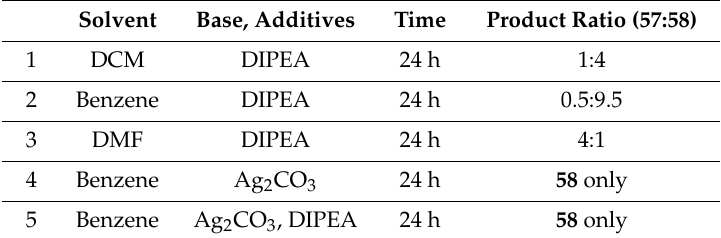
Table 2. Summary of conditions explored for protection of 56 with chloromethyl ethyl ether. Base, Solvent